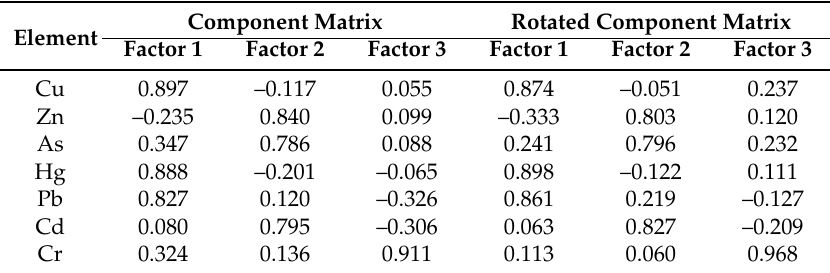
Table 8. Factor loading matrix of component matrix and rotated component